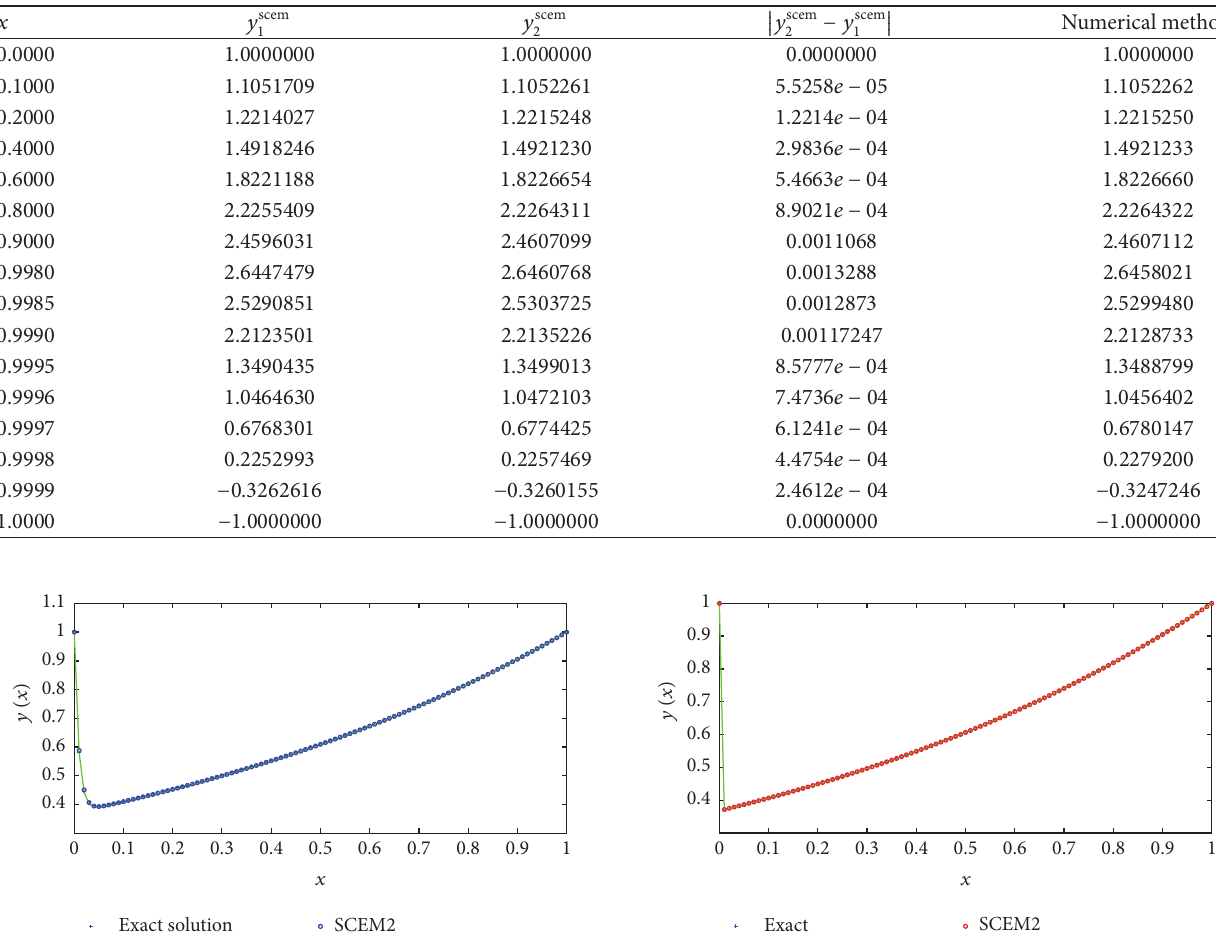
Table 3: Results of right layer problem for 𝜀 = 10 −3 and 𝛿 = 0.5𝜀 .